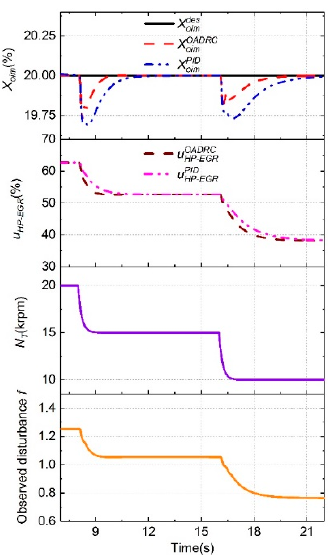
Figure 15. Disturbance rejection performance comparison with step change of N T. Table 8. Disturbance rejection performance comparison with step change of N T.